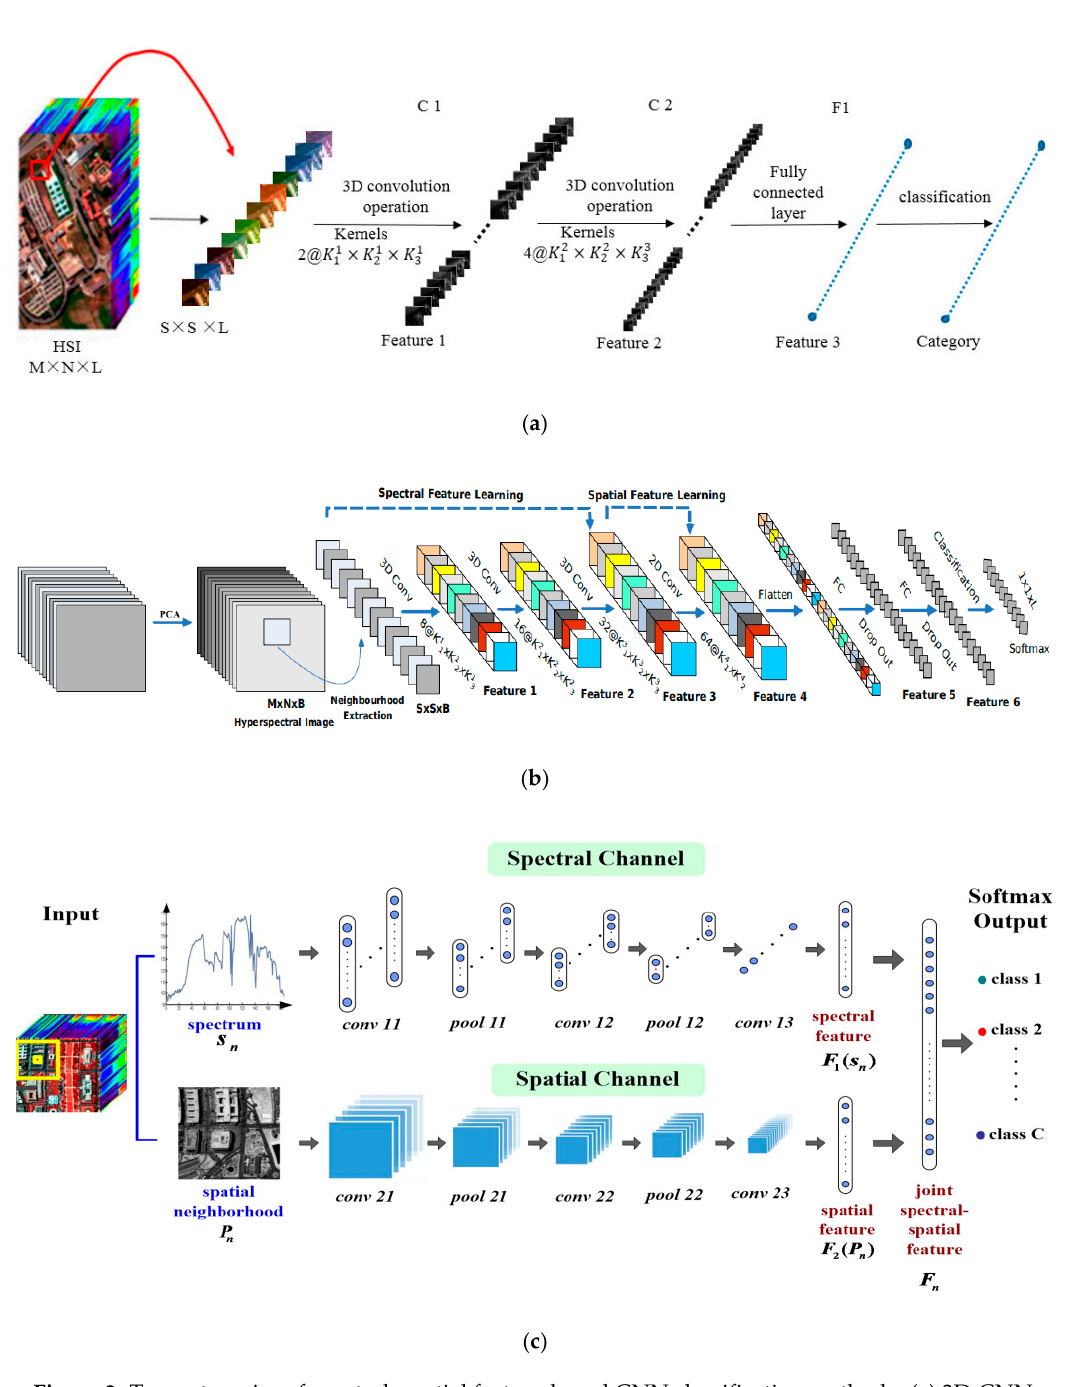
Figure 3. Two categories of spectral–spatial feature-based CNN classification methods. ( a ) 3D-CNN classification framework [30]; ( b ) a sequential 3D–2D hybrid CNN framework [38]; ( c ) a multi-channel 1D–2D hybrid CNN framework [37].